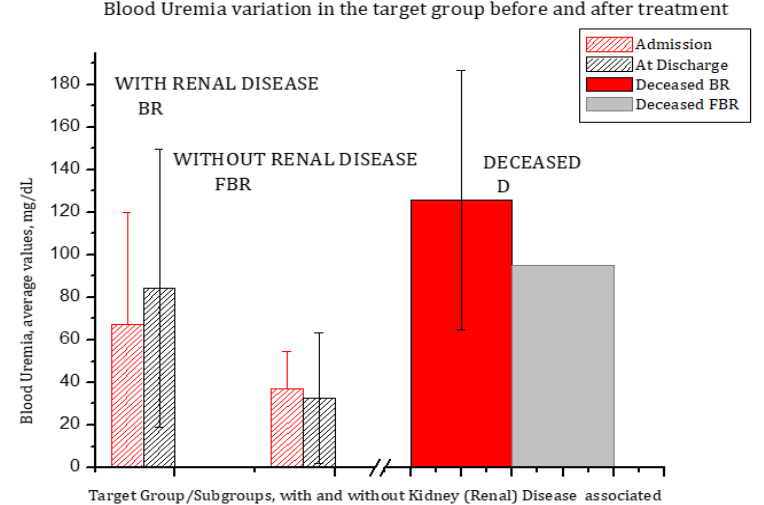
Figure 2. Uremia variation in the target group before and after antibiotic and antifungal treatment where BR= renal disease, FBR= without renal